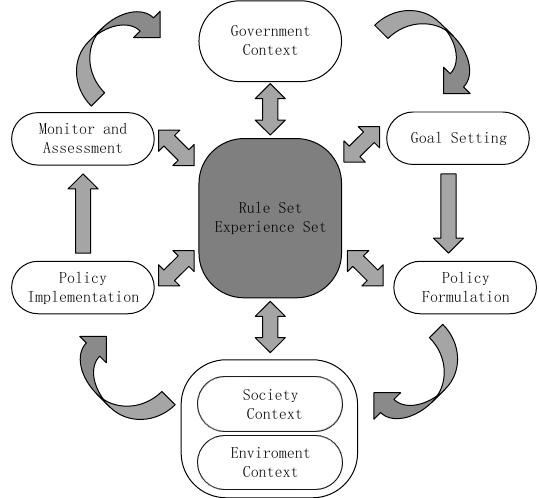
Figure 9. Learning cycle related to policy cycle. Government context module, society context module, environment context module refers to the participation of relevant agents.